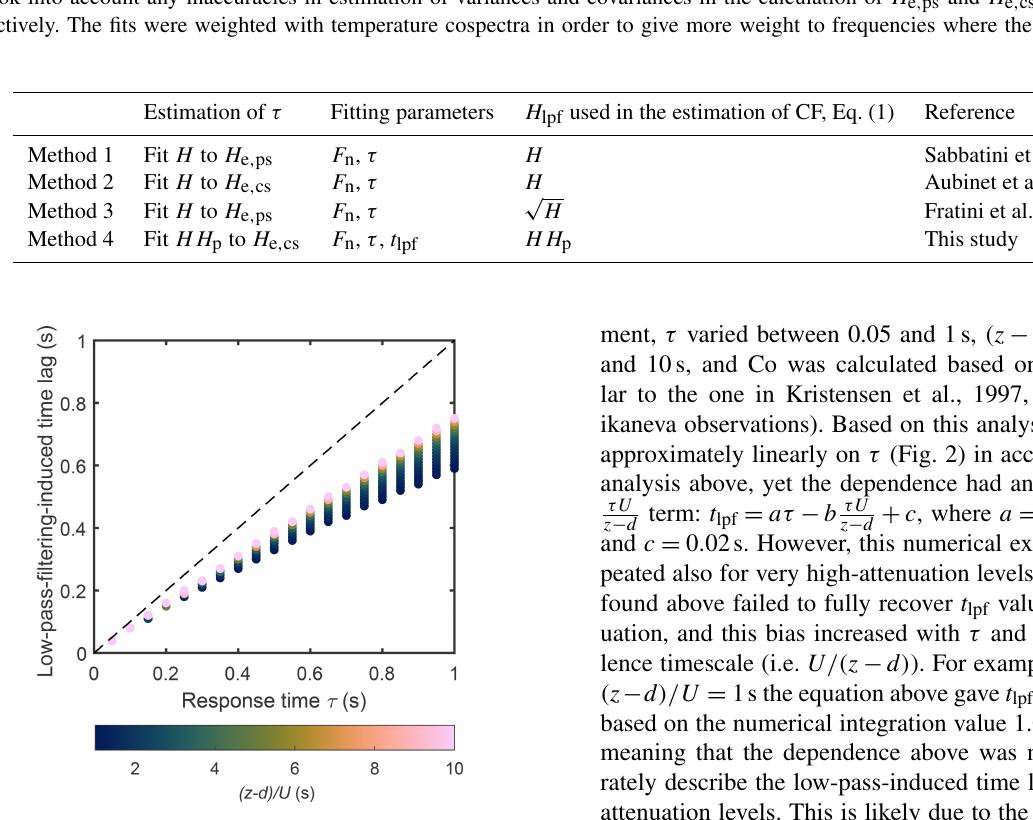
Figure 2. Low-pass-filtering-induced time lag ( t lpf ) plotted against response time ( τ ). The t lpf values were estimated by numerically integrating the integral in Sect. 2.2 with various time-lag values and evaluating which value resulted in maximum value for various τ and (z − d)/U combinations. The dashed line shows 1 : 1 corre- spondence. See Sect. 4.1 for more